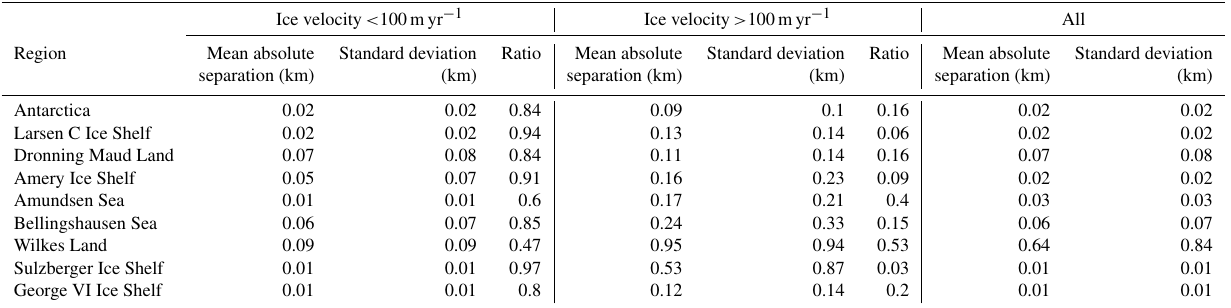
Figure 8. (a) Absolute separations between the ICESat-2-derived landward limit of tidal flexure (Point F) and Sentinel-1a/b DInSAR- derived Point F in 2018 (Mohajerani et al., 2021). (b) Absolute separations in areas where the ice velocity is lower than 100myr − 1 (Rignot et al., 2017), (c) absolute separations in areas where the ice velocity is higher than 100myr − 1 (Rignot et al., 2017). In all subplots, data are superimposed over the recent mass change map (Smith et al., 2020b) and IMBIE basin boundary (Shepherd et al., 2018; Rignot et al., 2011b). Table 2. Mean absolute separation (km) and standard deviation (km) between ICESat-2-derived landward limit of tidal flexure (Point F) and 2018 DInSAR-derived Point F (Mohajerani et al., 2021) in individual